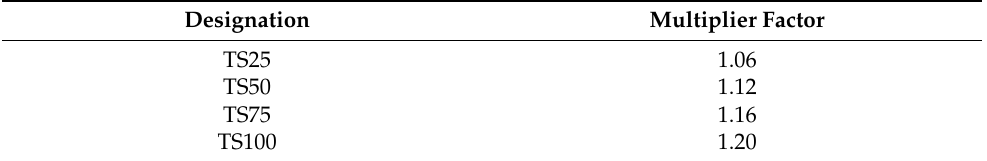
Table 4. The Multiplier factors for tin slag mortars.